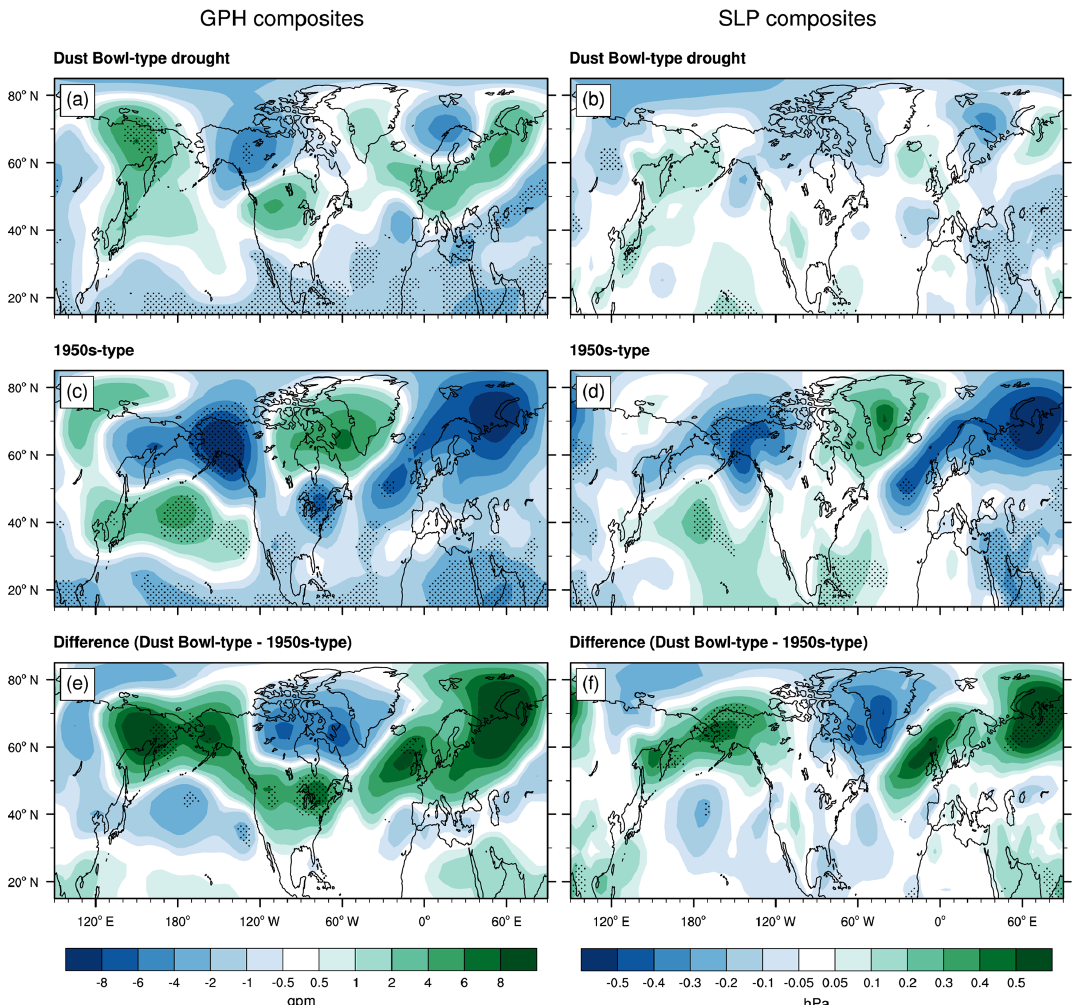
Figure 2. Composites of 500hPa geopotential height anomalies (a, c, e) and sea-level pressure anomalies (b, d, f) from EKF400 for Dust Bowl-type droughts (a, b) , 1950s-type droughts (c, d) , and their difference (e, f) . Stippling indicates significance ( p < 0 . 05) based on a non-parametric Wilcoxon–Mann–Whitney